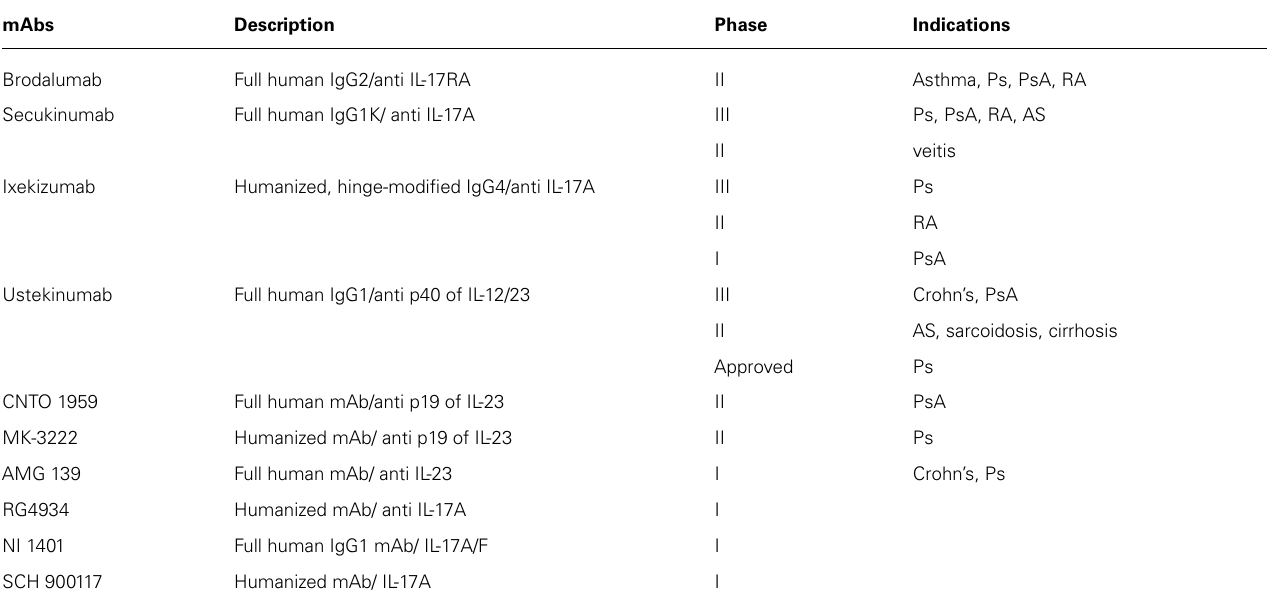
Table 1 | Monoclonal antibodies against IL-17 pathway clinical